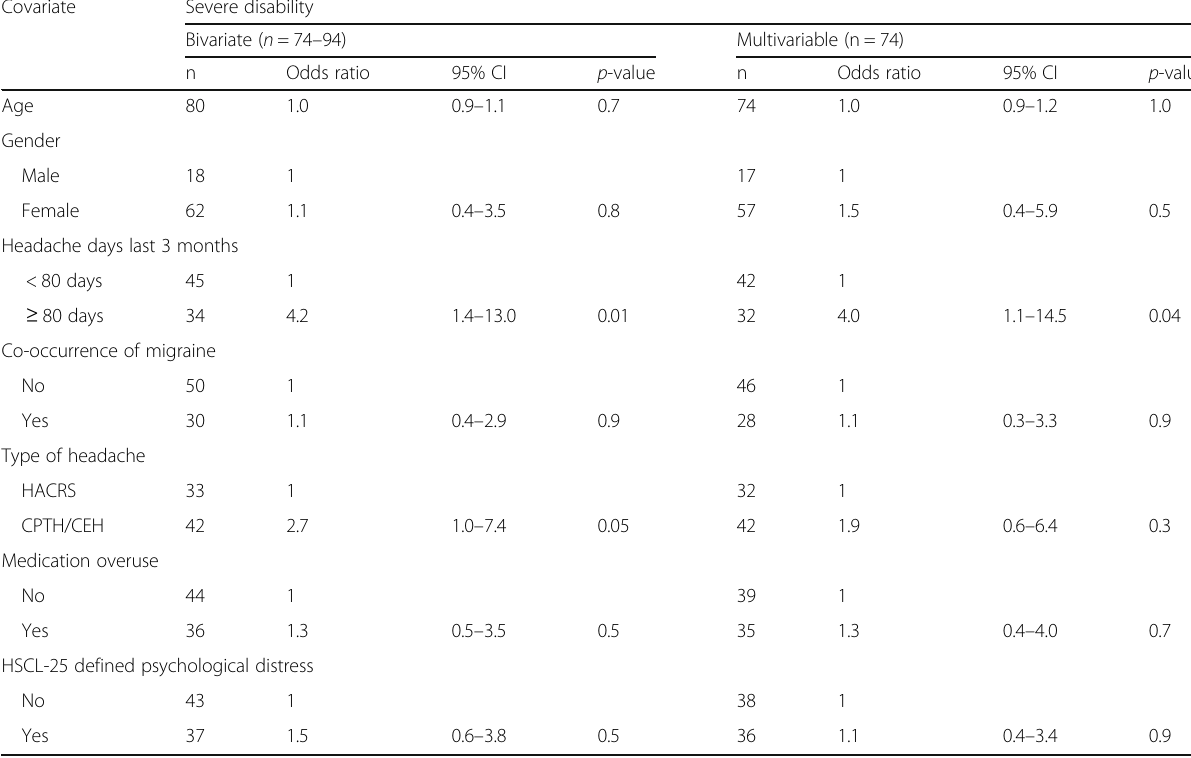
Table 4 Odds for having severe disability defined as MIDAS score > 20. Logistic regression